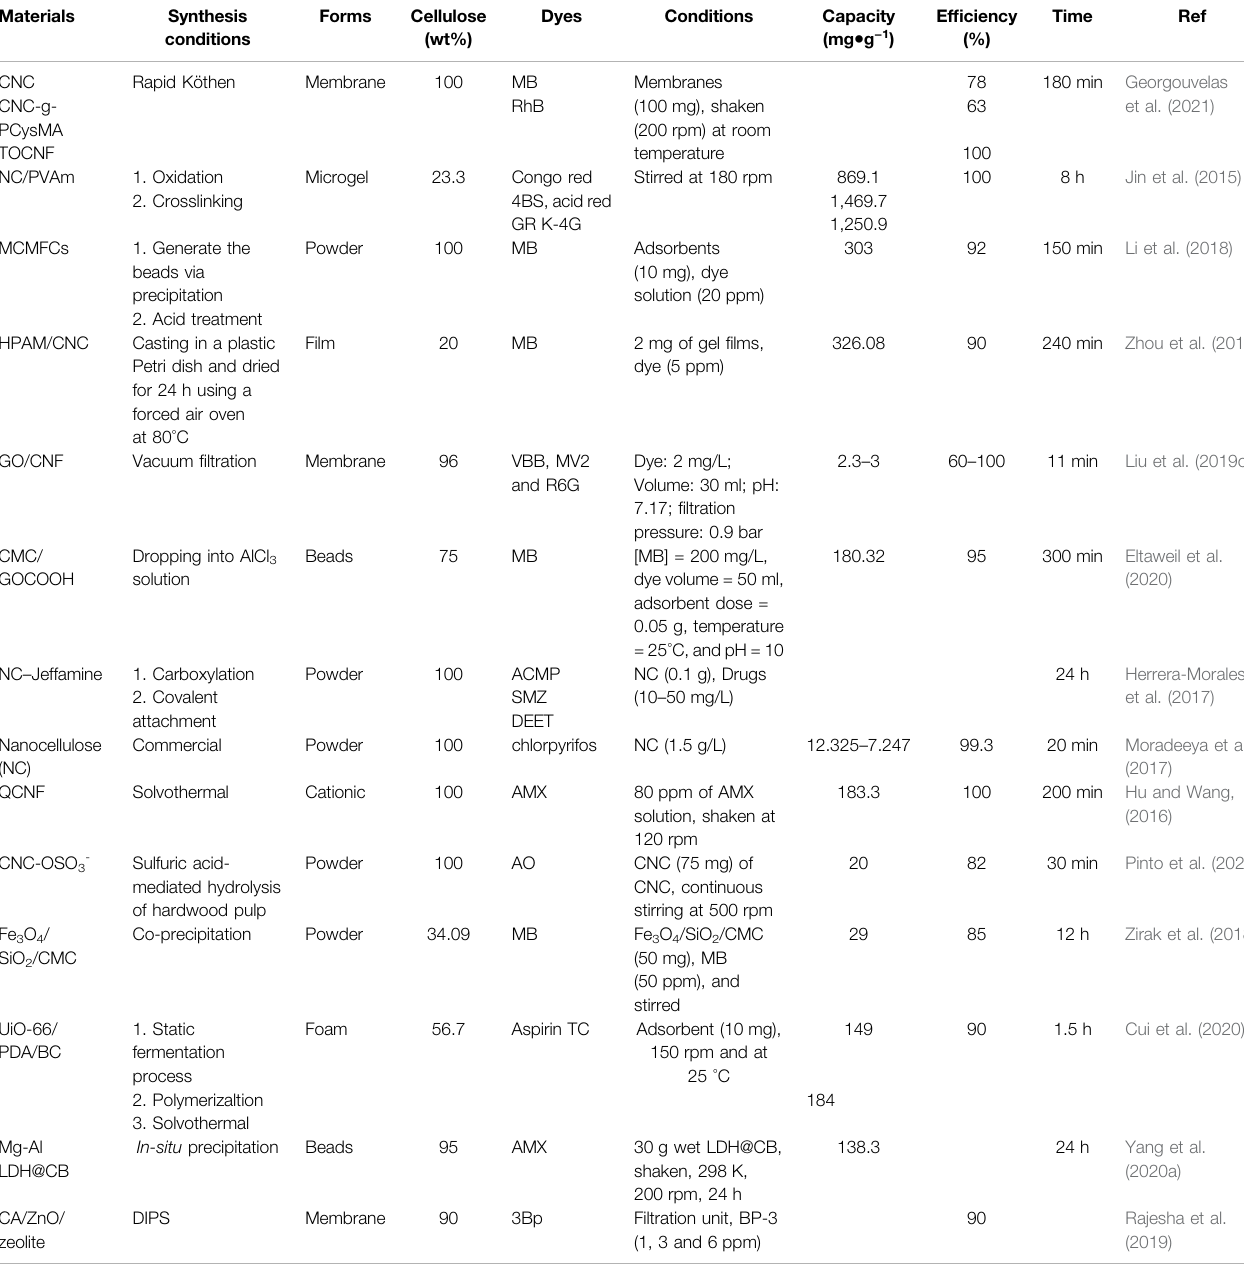
TABLE 4 | Pollutants removal using cellulose-based materials via